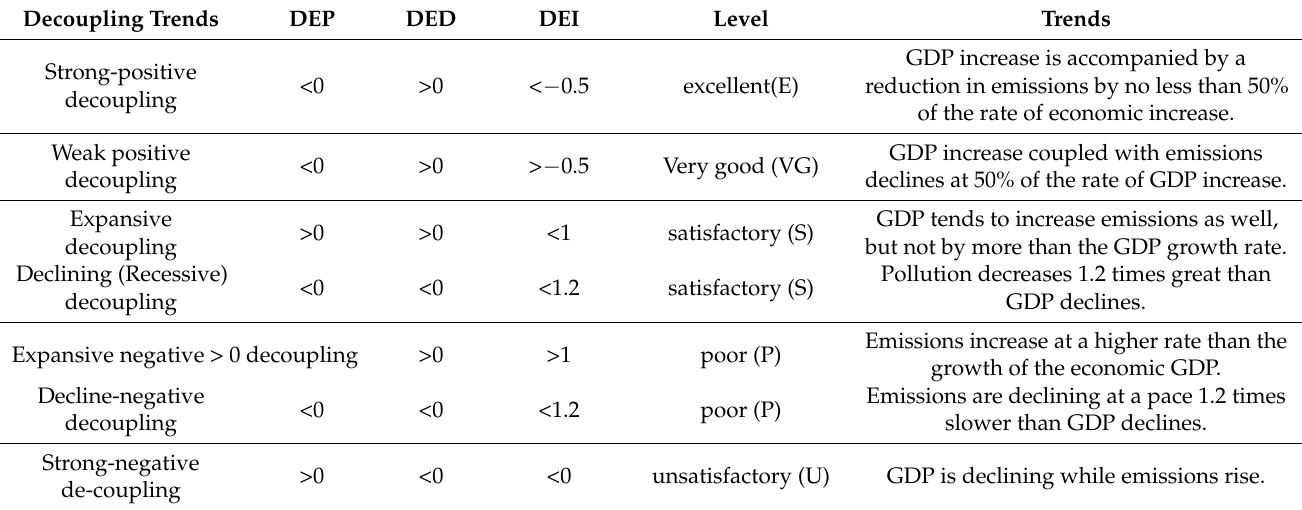
Table 3. Evaluation of eco-efficiency WEF’s GHG